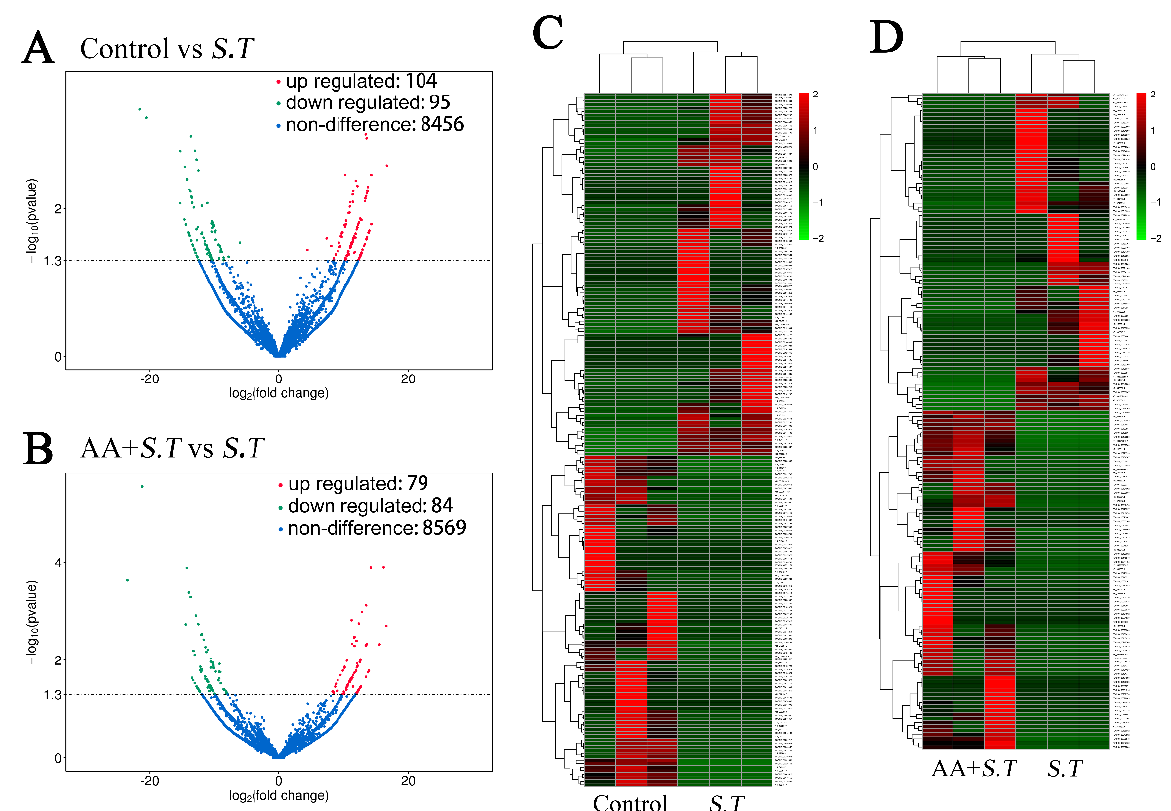
Figure 1. Differentially Expressed Transcripts and Gene Profiles. Volcano plots showing lncRNAs in microglia. ( A ) Significantly differentially expressed lncRNAs between S.T and control. ( B ) Significantly differentially expressed lncRNAs between S.T group and AA + S.T group ( n = 3, p < 0.05). Heatmaps showing significant differential lncRNA expression in microglia. ( C ) Differentially expressed lncRNAs between S.T group and control. ( D ) Differentially expressed lncRNAs between S.T group and AA + S.T group. ( n = 3, p < 0.05). Data represent the control, S.T group and AA + S.T group, n = 3 per group.